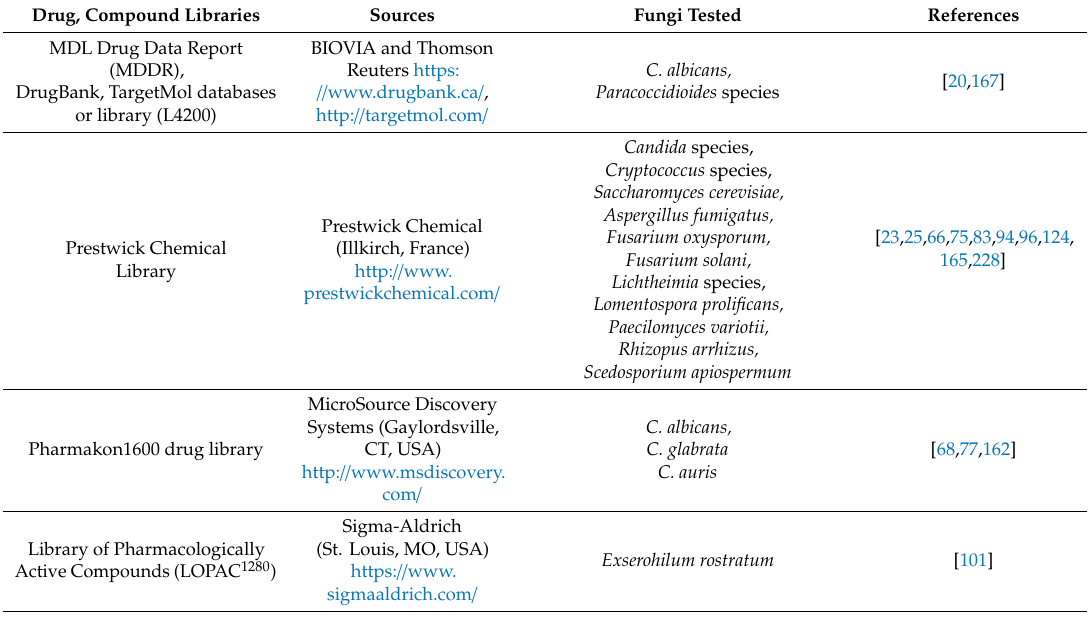
Table 4. Summary of the drug / compound libraries used in the antifungal drug repurposing (see also Table S1, Supplementary